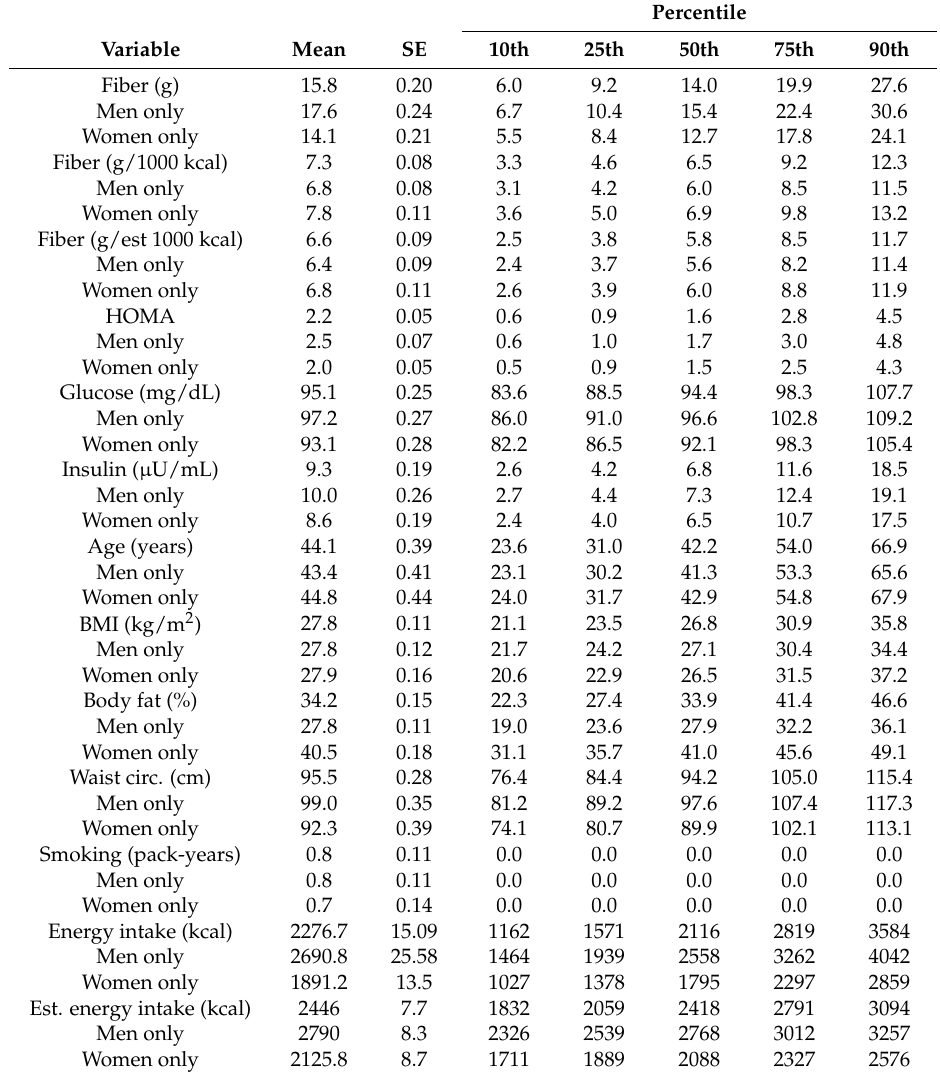
Table 1. Descriptive characteristics of the key variables ( n =